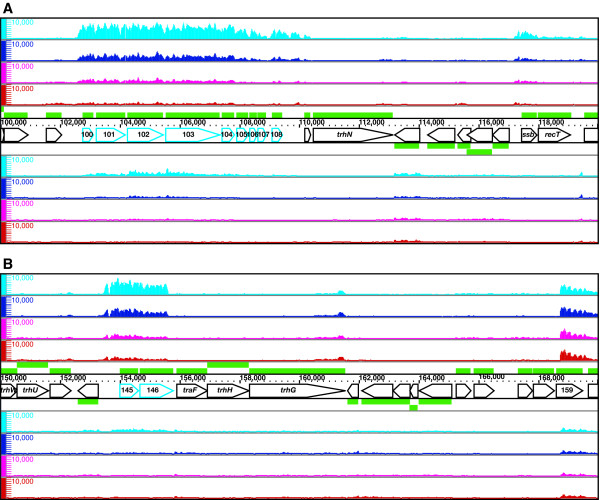
High-resolution mapping of ORF100-108 (A) and ORF145-146 (B), differentially transcribed operons between KT2440(pCAR1) and CA10. Single-stranded cDNA from KT2440(pCAR1) grown on succinate (cyan) or carbazole (blue) and from CA10 grown on succinate (magenta) or carbazole (red) was mapped on both strands of pCAR1, which are transcribed from left to right (above) and from right to left (below). Pentagons represent the pCAR1 genes and their transcriptional directions; the gene names or ORF numbers are indicated therein. The scale bars indicate the signal intensities from 0 to 10,000 on a linear scale.